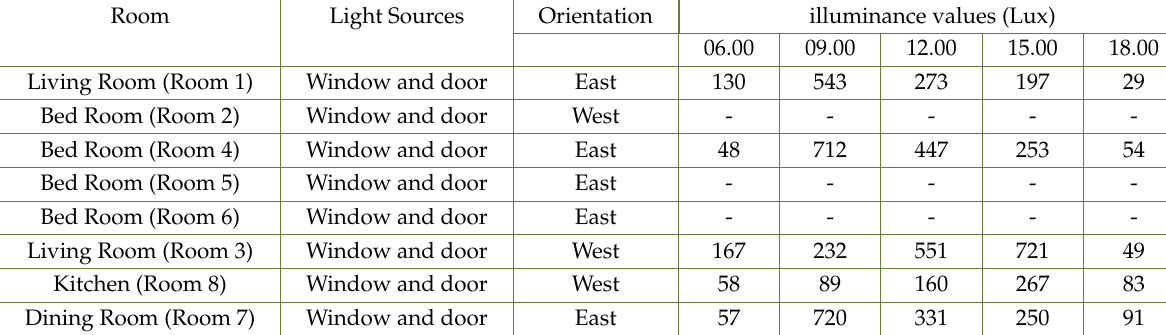
Table 2. Results of field measurement of illuminance